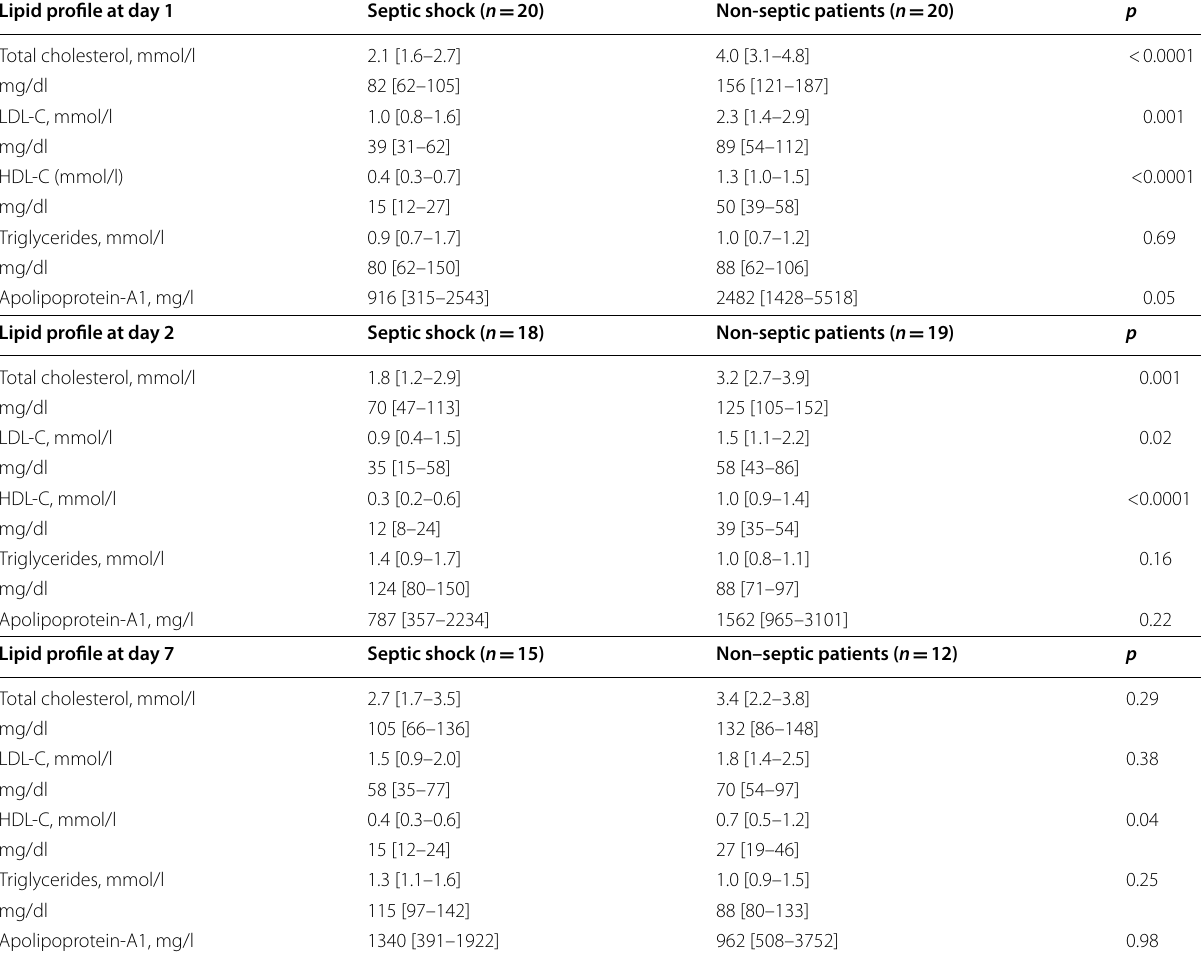
Results are expressed as medians (IQR). The statistical differences were analyzed by a Mann–Whitney